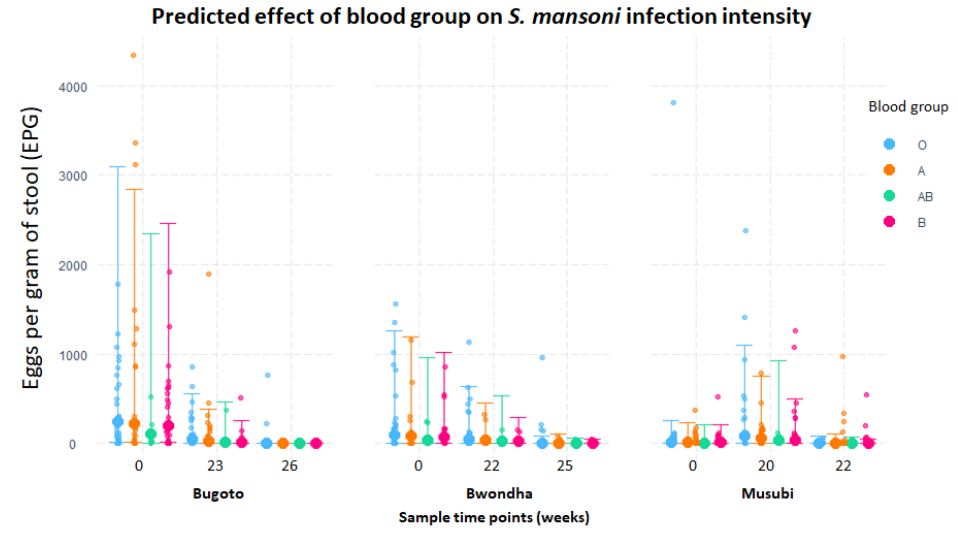
Figure 3. Relationship between blood group and infection intensity (eggs per gram of stool (EPG)) categorised by village school. The colour-coded effect lines underlaid by raw data points illustrate the model predictions that there is no significant association between blood group and EPG.